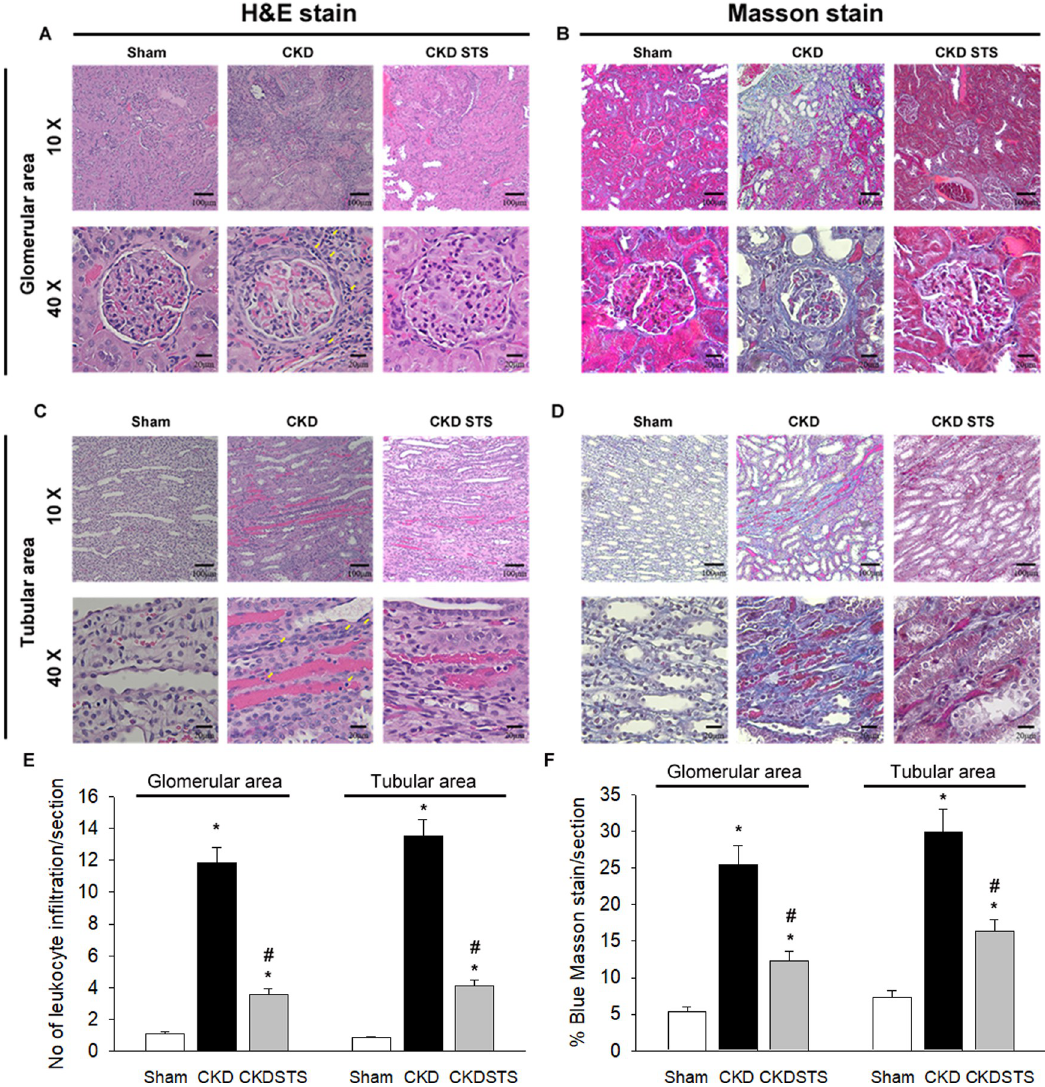
Fig 5. Histologic graphs from H&E stain (A, C) and Masson stain (B, D) were displayed in sham, CKD and STS treated CKD (CKD STS) rats. The increased leukocytes infiltration (yellow arrows) is indicated in the tubular area of the CKD kidney (A, C). Increased masson stain by blue color is indicated in the glomerular (B) and tubular areas (D) of the CKD kidneys. The mean data of number of leukocyte infiltration and % of blue Masson stain for each section is indicated in E and F, respectively. Data are expressed as mean ± SEM (n = 6). � P < 0.05 vs. Sham. # P < 0.05 vs. CKD.